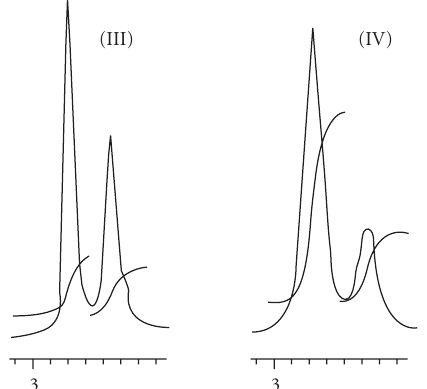
Figure 2: 1 H-RMN, relative areas of the signal attributed to CH 2 adjacent to the thiophene ring for poly[3-(6-clorohexyl)thiophene] (III) and poly[3-(6-bromohexyl) thiophene] (IV).